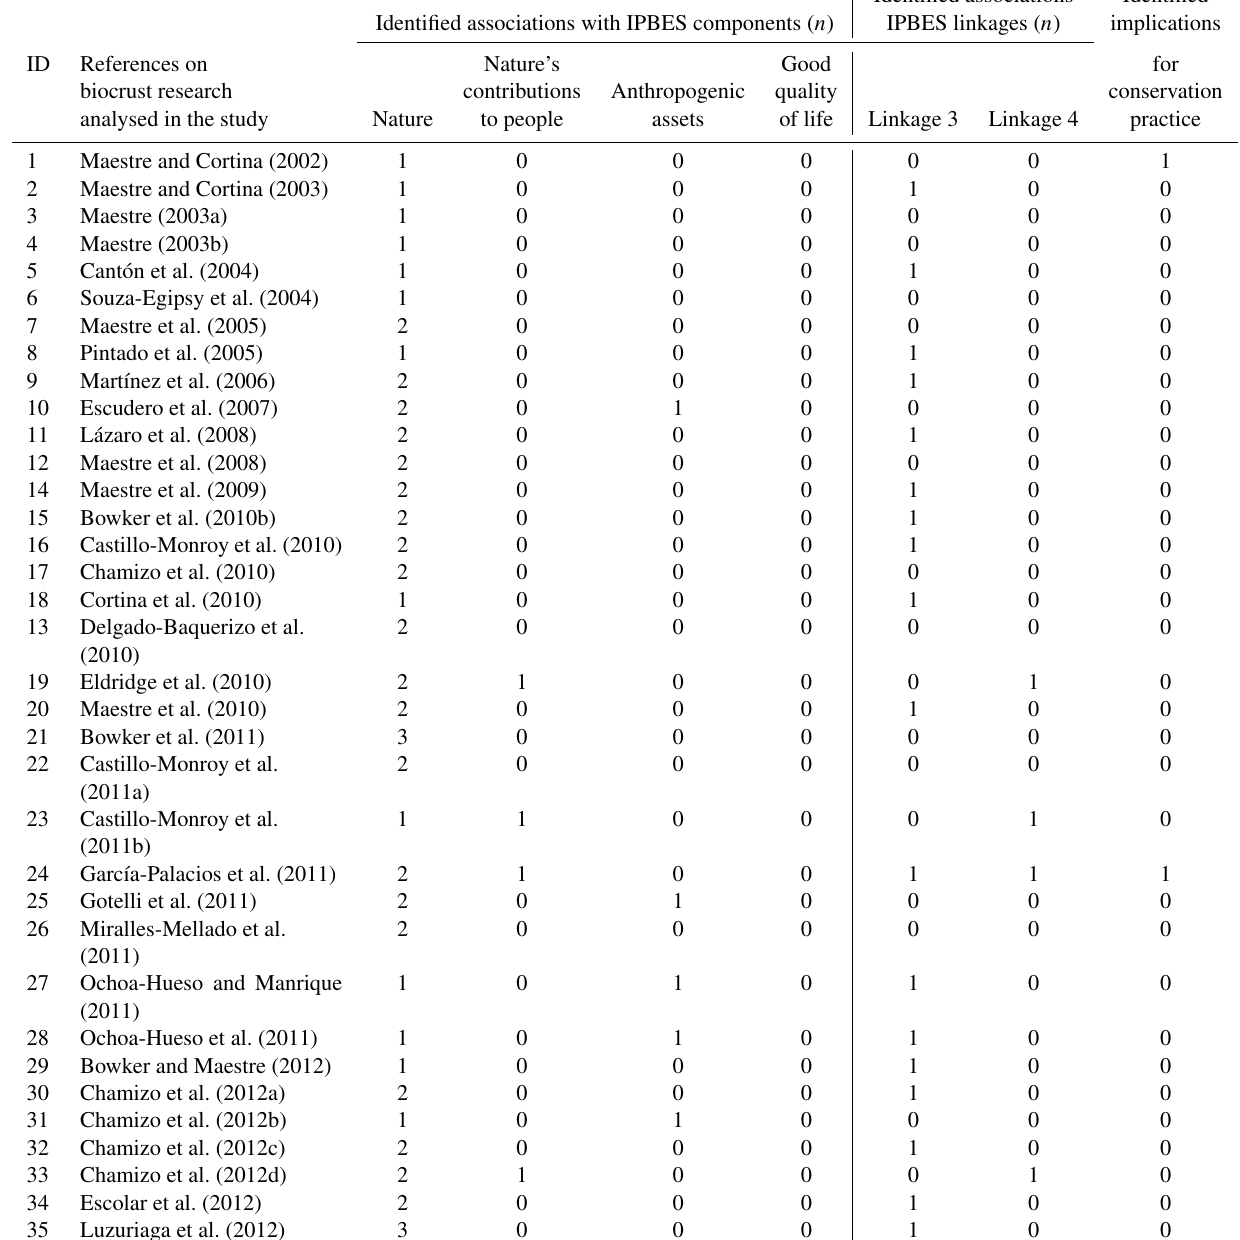
Table B1. List of references on biocrust research analysed in the study and identified associations in four of the six IPBES components (nature, nature’s contributions to people, anthropogenic assets, and good quality of life) and 2 of the 10 linkages (“linkage number 3” (linkage between direct drivers of change and nature) and “linkage number 4” (linkage between nature and nature’s contributions to people)). Those IPBES elements for which no associations were identified are not included in the table. Identified implications for conservation practice in references are also shown. Full references can be found at the end of the